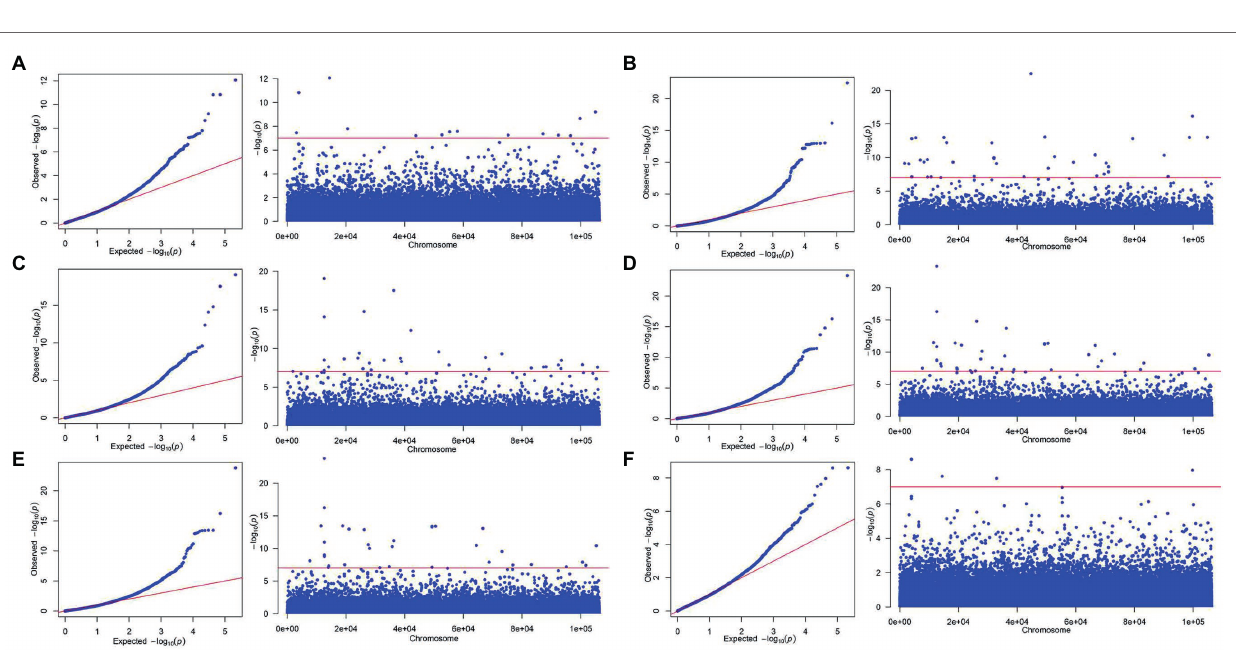
FIGURE 4 | The qq-plot and manhattan of genome-wide association studies for secondary metabolite contents based on MLM. (A) Luteolin, (B) pinocembrin, (C) apigenin, (D) naringenin, (E) DK, and (F)